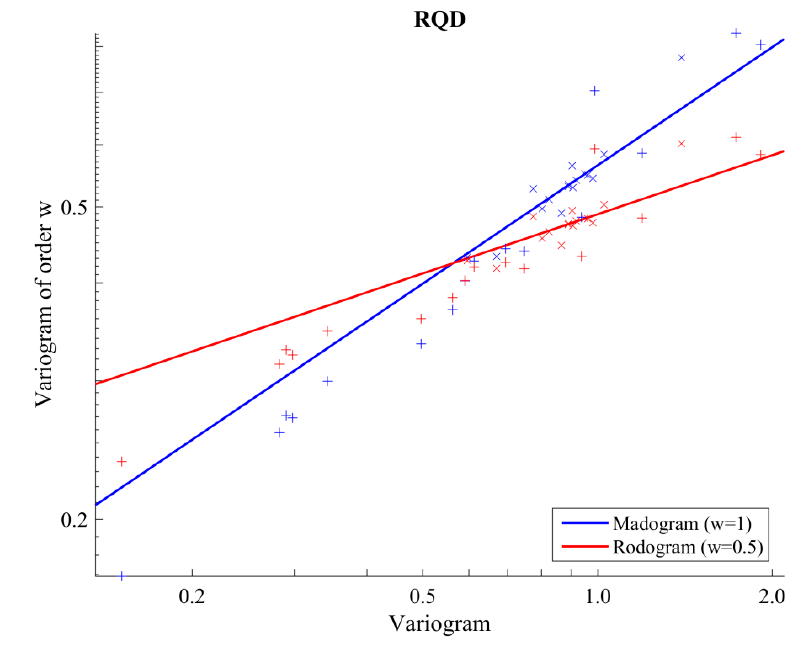
Figure 7. Experimental madograms and rodogram of the Gaussian variables as a function of their experimental variograms.